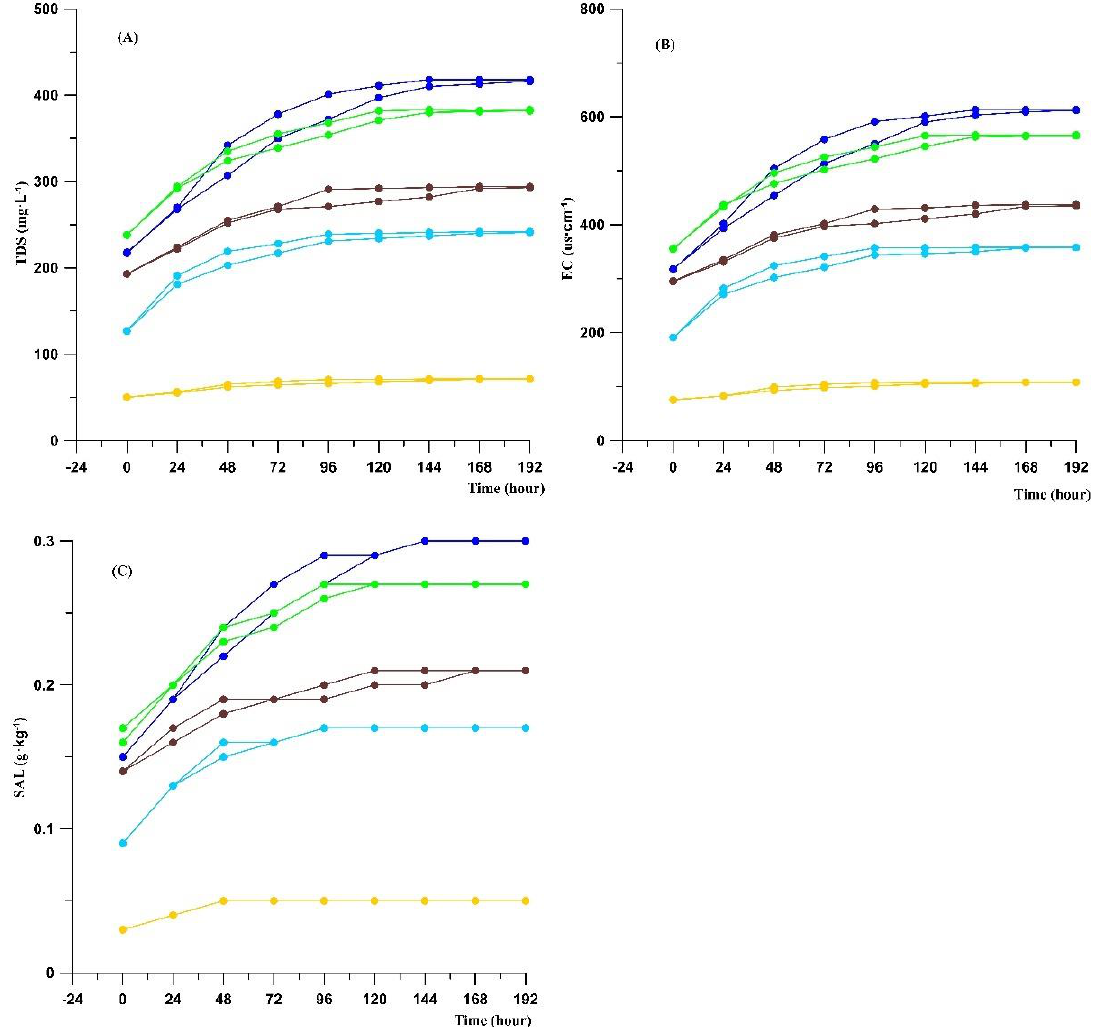
Figure 4. Change curve of the physicochemical property indexes of sediment lixivium with and without stirring with time (different color symbol lines represent the test result of different sediment lixivium, with the top same color symbol line being the test results under stirring, and the bottom the test results without stirring. ( A ): Change curve of TDS of sediment lixivium with time; ( B ): Change curve of EC of sediment lixivium with time; ( C ): Change curve of SAL of sediment lixivium with time).